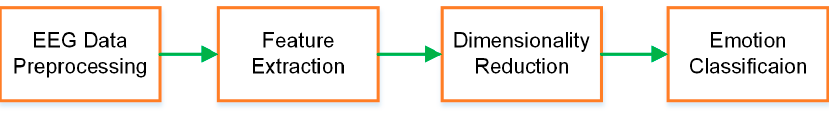
Figure 5. Block diagram of emotion recognition.